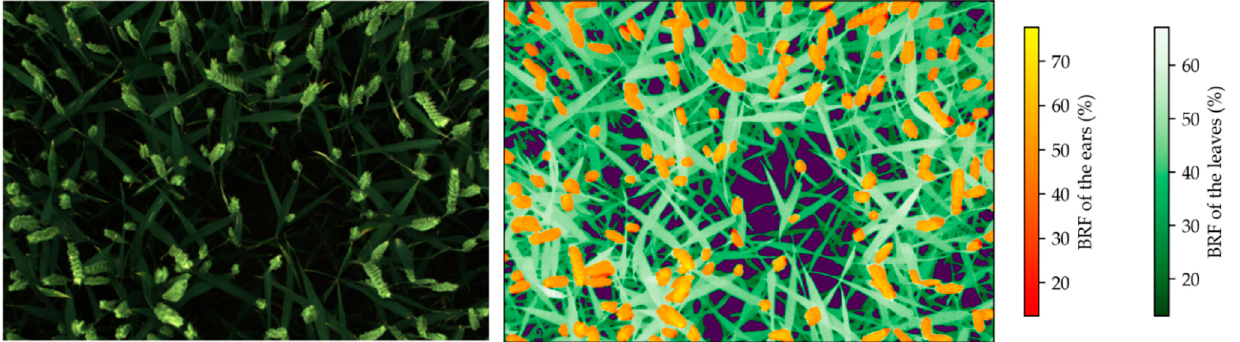
Figure 3. To the left, a registered RGB image. To the right, the corresponding registered and segmented bi-directional reflectance factor (BRF) map in the 800 nm channel. The color bars indicate the BRF values separately for ears and leaves. The dark purple regions in the image represent the background.